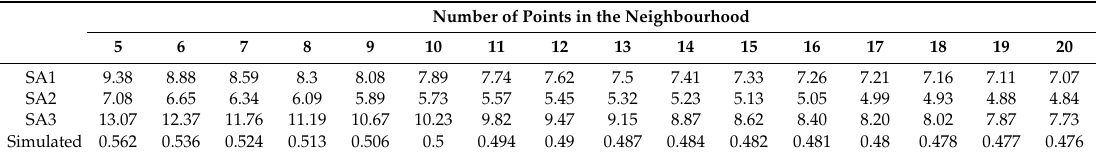
Figure 10. Plot of the aspect RMSE with number of points in the neighbourhood in study areas 1–3 and simulated data. Table 11. RMSE of the slope (degrees) extracted from the interpolated DEM of study areas 1–3 and simulated data.